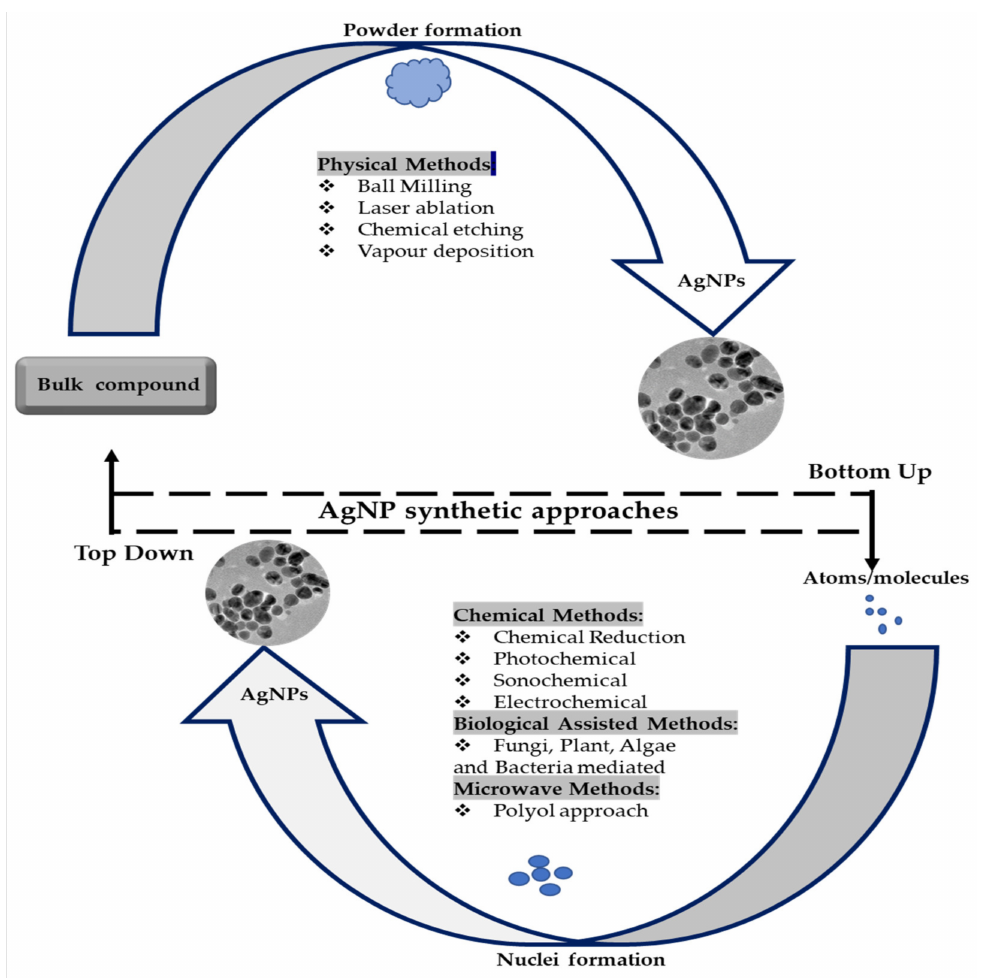
Figure 2. The bottom-up and top-down approaches for nanoparticle synthesis. Adapted from